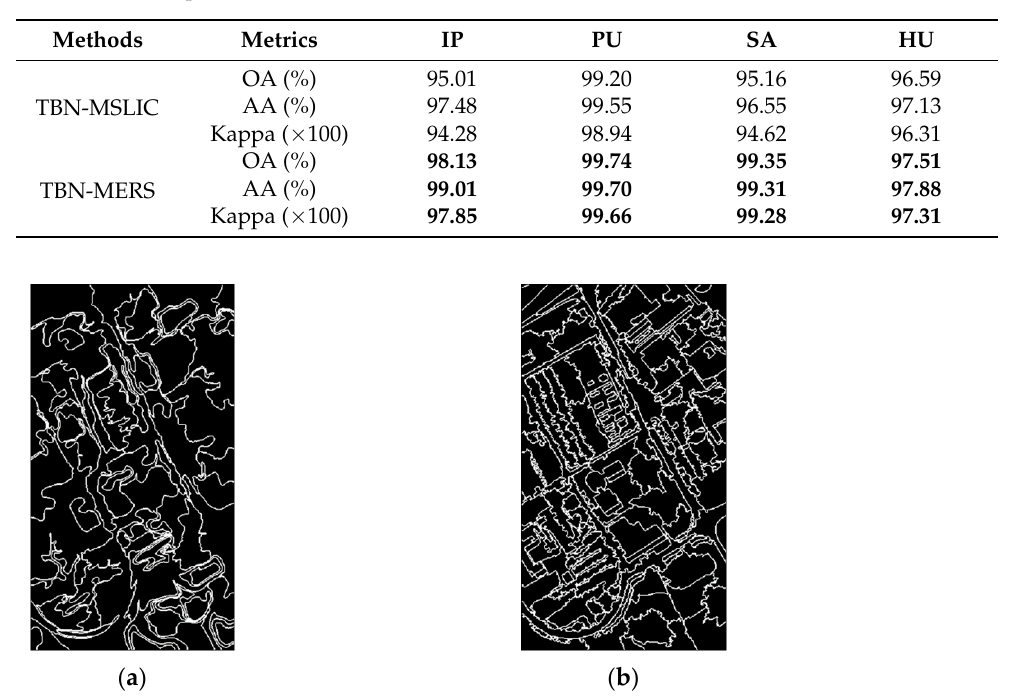
Table 7. The comparison results of TBN-MSLIC and TBN-MERS.